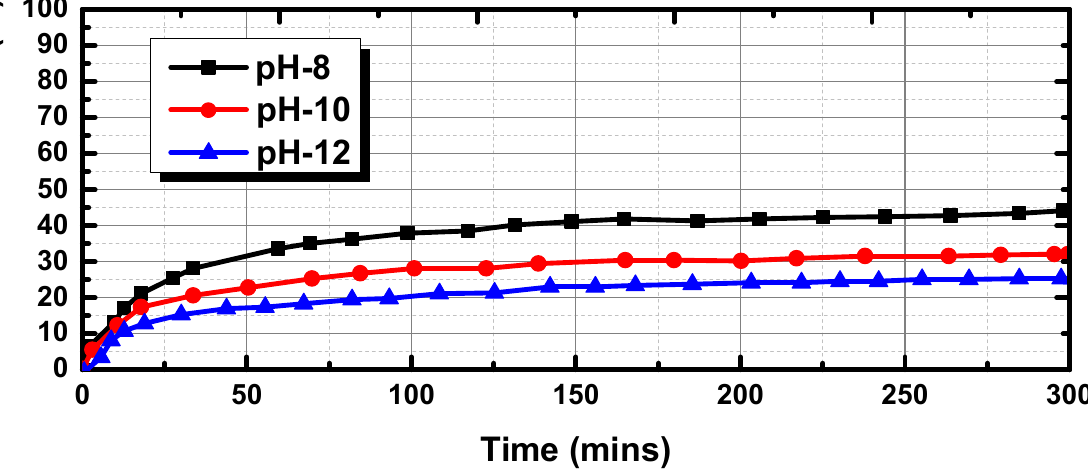
Figure 9. Comparison of the cumulative amount of MB released as a function of time at different pH values.